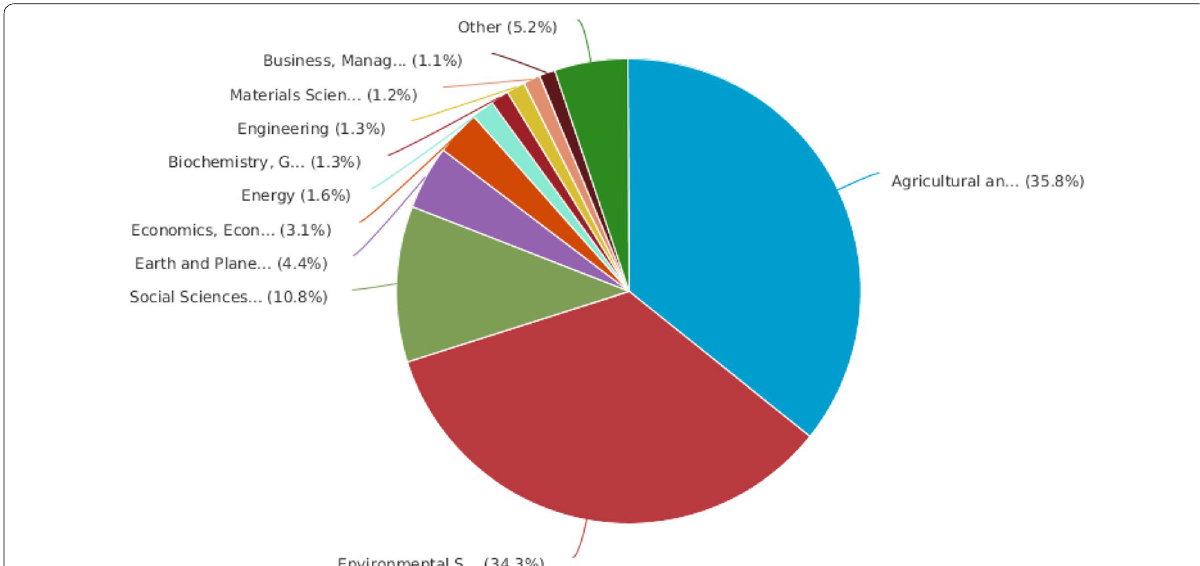
Fig. 4 The percentage of ecosystem service publication based on subject areas. This figure stated authors’ background who published articles in relation to ecosystem services. Most of the articles were published from authors with agricultural and biological, and environmental science